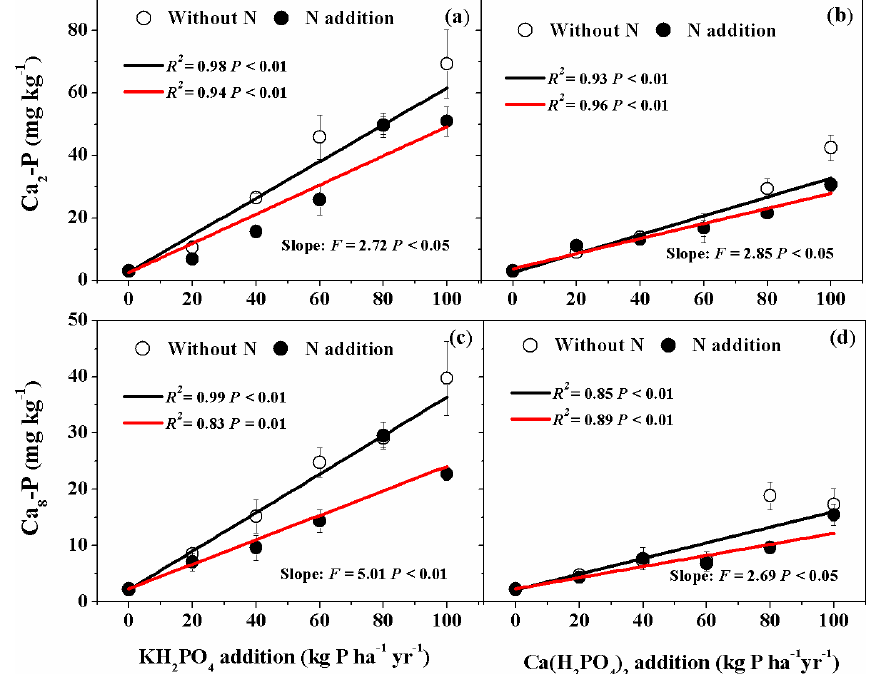
Figure 3. Effects of phosphorus (P) and nitrogen (N) additions on soil dicalcium phosphate (Ca 2 -P) and octacalcium phosphate (Ca 8 - P). Phosphorus types include KH 2 PO 4 and Ca ( H 2 PO 4 ) 2 at rates of 0, 20, 40, 60, 80 and 100kgPha − 1 yr − 1 . Data are represented as mean ± standard error. Fitted lines are based on linear regression models. The black and red lines represent without N and N addition, respectively. Significance was labeled for slopes of the black and red lines.